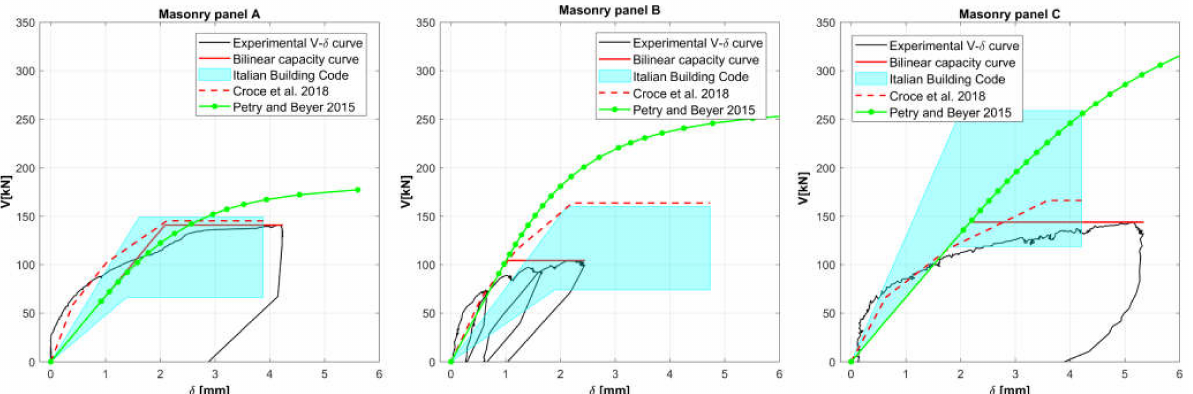
Figure 15. Shear response of tested masonry panels A, B, and C: experimental one (in black), equivalent bilinear capacity curve from the experimental one (solid red lines), possible range according to [19] (in cyan), capacity curves evaluated based on the procedure proposed in [7] (dashed red lines), and analytical model [38] (green